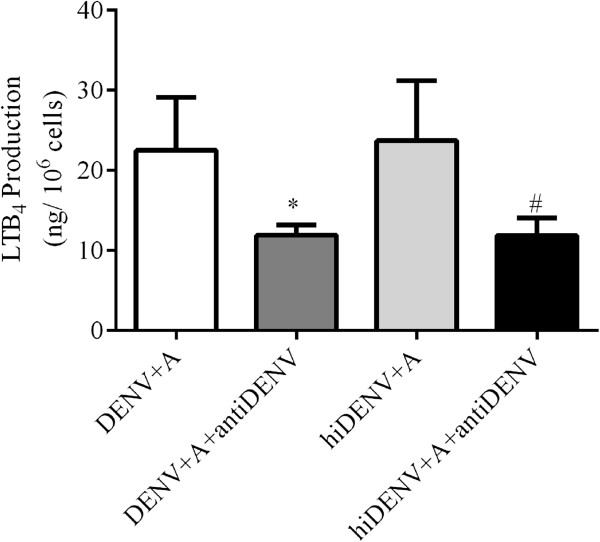
Production of leukotriene B4 by neutrophils incubated with or without anti-DENV-2 antibody. Production of leukotriene B4 (ng/106 cells) from freshly isolated peripheral neutrophils after 5-hour incubation in the presence and absence of anti-DENV-2 antibody (antiDENV), with live DENV-2 (DENV), heat-inactivated DENV-2 (hiDENV) and A23187 (A) treatment (N = 5). * p < 0.05 vs DENV + A using one-way ANOVA analysis with Bonferroni adjustments. # p < 0.05 vs hiDENV + A using one-way ANOVA analysis with Bonferroni adjustments.